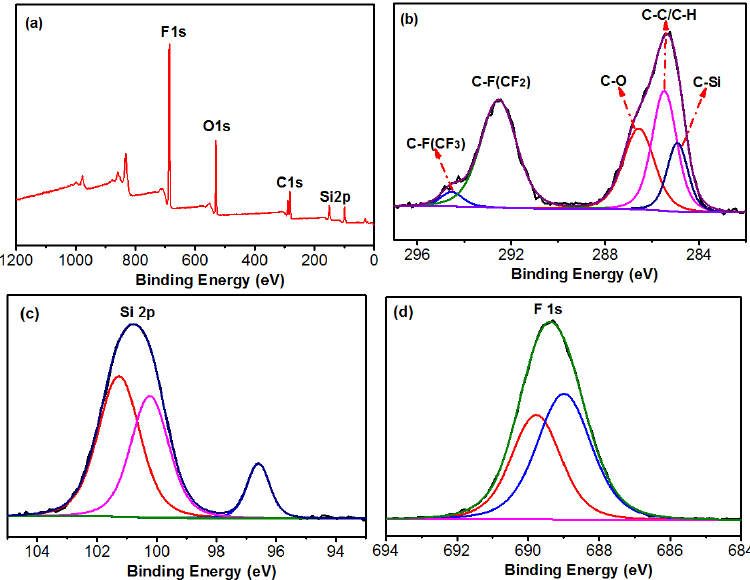
Figure 8. XPS and high-resolution spectra of FVPS on the silicon wafer: ( a ) wide scanning; ( b ) C1s; ( c ) Si2p; and ( d ) F1s.